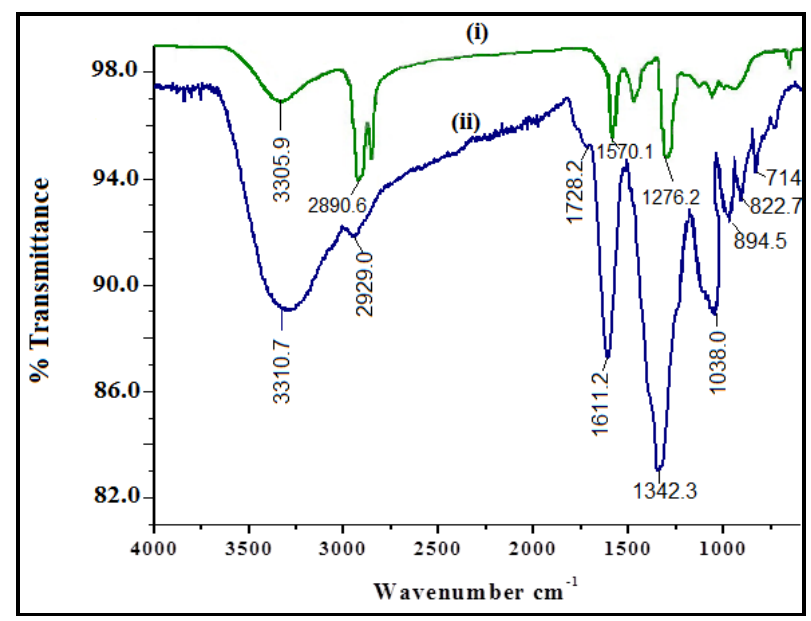
Figure 5. Fourier transform infrared spectroscopy (FTIR) spectra of ( i ) P. acerifolium leaf extract; ( ii ) P. acerifolium -synthesized CuO nanoparticles.